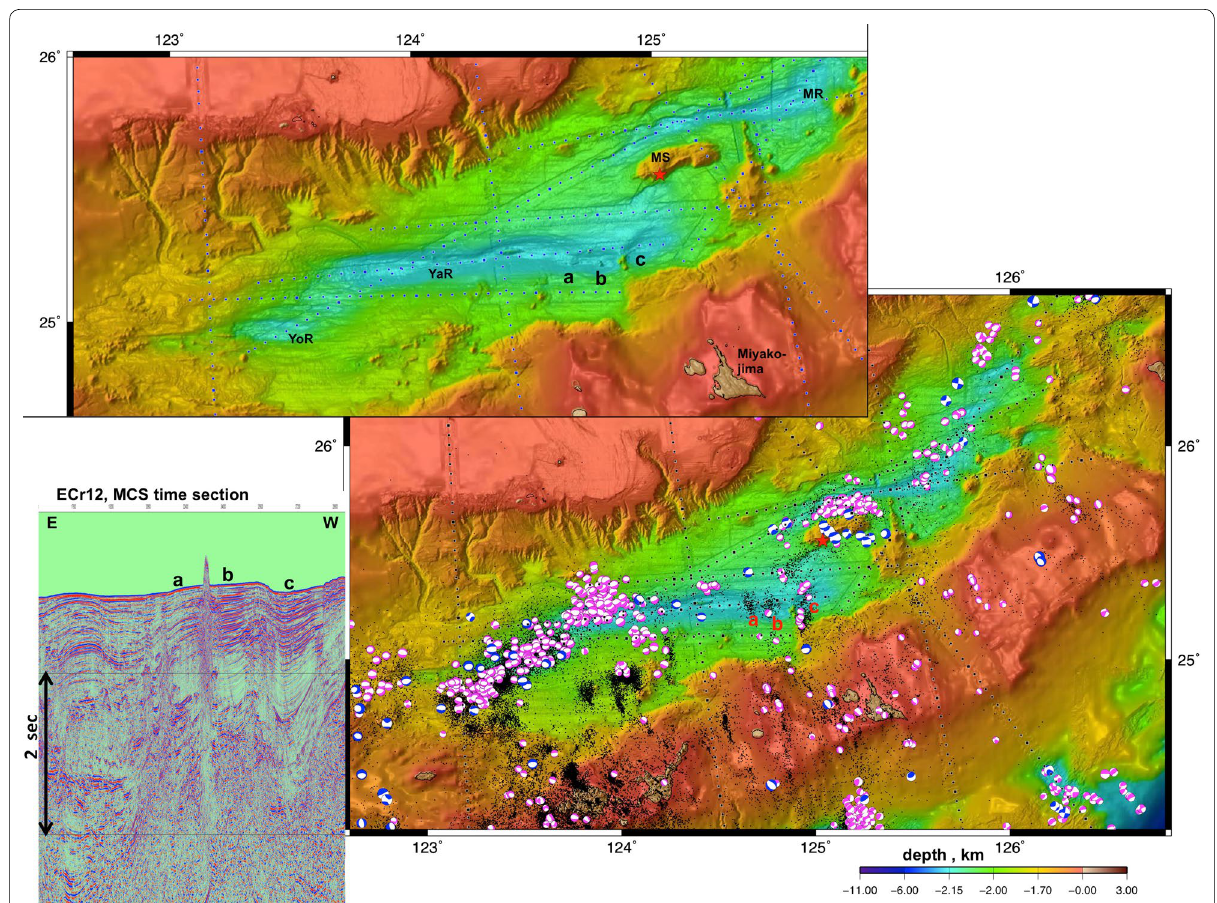
Fig. 18 (Top) Fine seafloor topography around Yaeyama Rift. Blue squares and a red asterisk in the topographic maps are positions of the OBSs and the epicenter of the 1938 M 7.2 Miyako-jima–Hokusei-oki Earthquake, respectively. YoR Yonaguni Rift, YaR Yaeyama Rift, MR Miyako Rift, MS Miyako Seamount. (bottom right) Shallow (focal depths 30 km) seismic activity on the bathymetric map. Black dots show epicenters determined ≤ by the JMA (1923–2018, February). Pink focal mechanisms are from the F-net CMT Catalog by NIED (1997–2018, February), and blue are from the GCMT Catalog by Global Centroid-Moment-Tensor Project (1976–2018, February). Three seismic clusters of a, b, and c on the bathymetric maps are projected on the MCS profile (time section) for ECr12 on the bottom